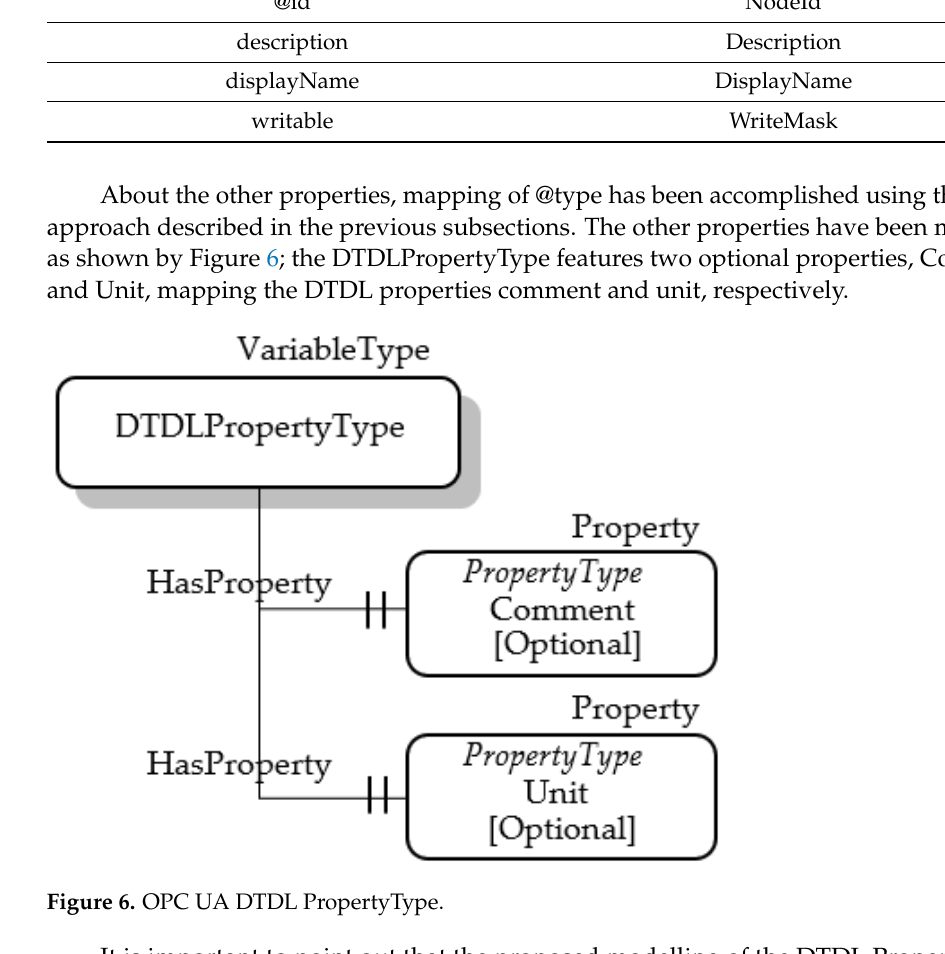
Table 8. Mapping of properties of the Property class into OPC UA DTDL PropertyType attributes.